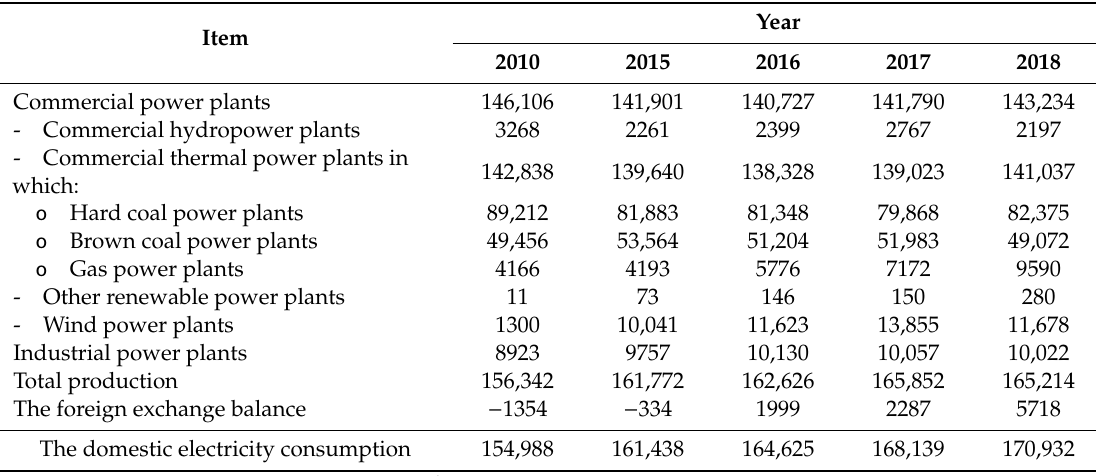
Table 3. The structure of electricity production in domestic power plants, the volume of electricity exchange with foreign countries, and the energy consumption in Poland in 2015, 2016, 2017, and 2018 (GWh) 1